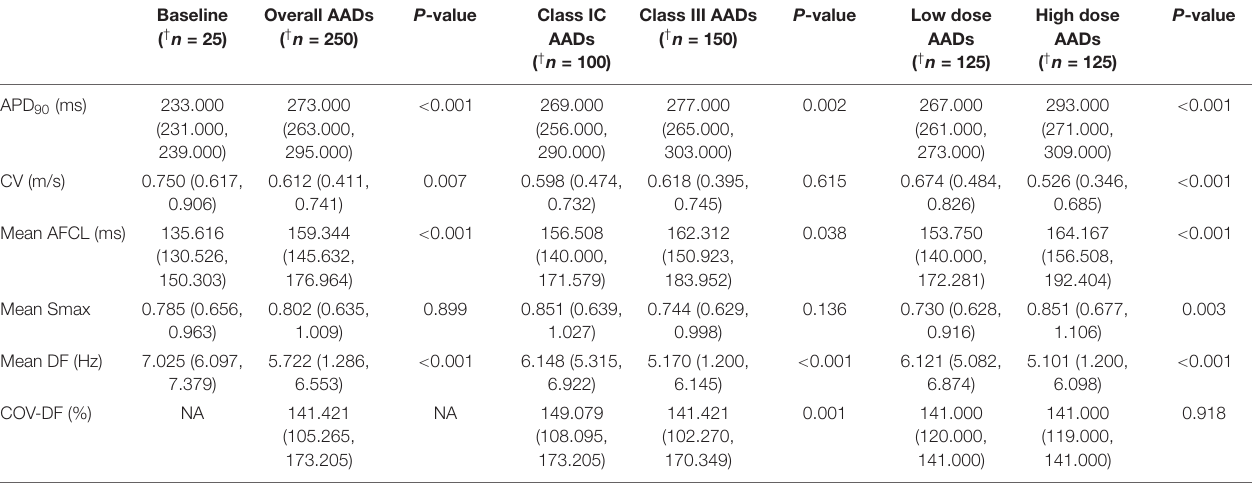
TABLE 1 | Effects of antiarrhythmic drugs (AADs) on the electrophysiological and fibrillatory wave-dynamics parameters.